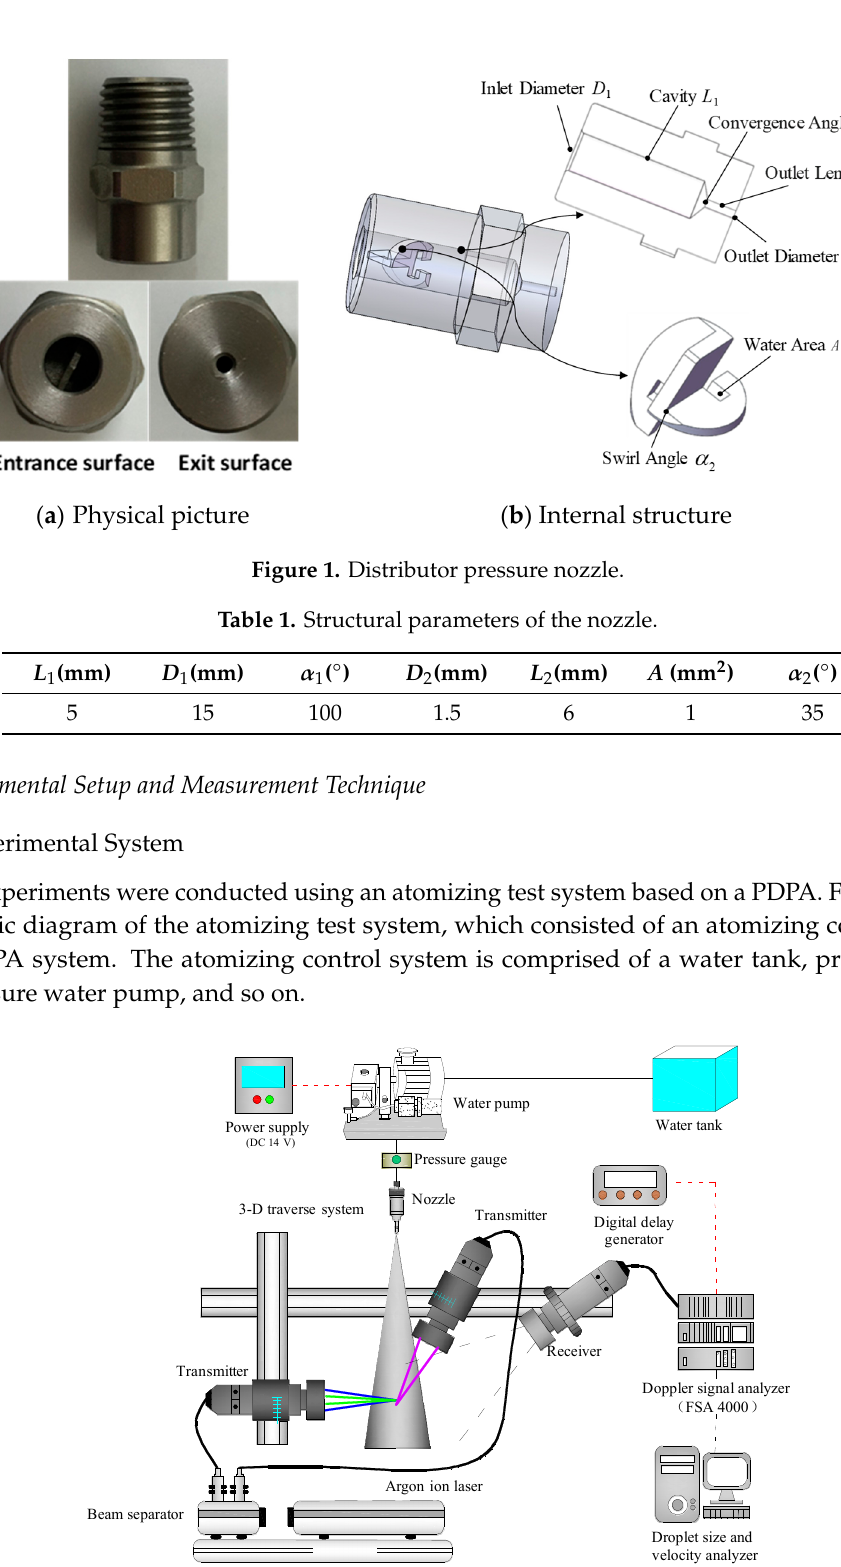
Figure 2. Schematic diagram of the atomizing test system.